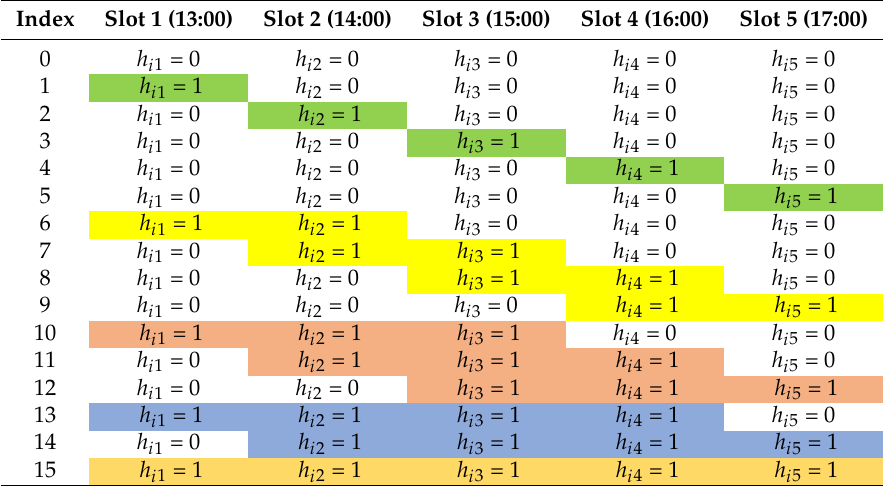
Table 1. Possible combinations of 0, 1, 2, . . . , M connected time slots for M =